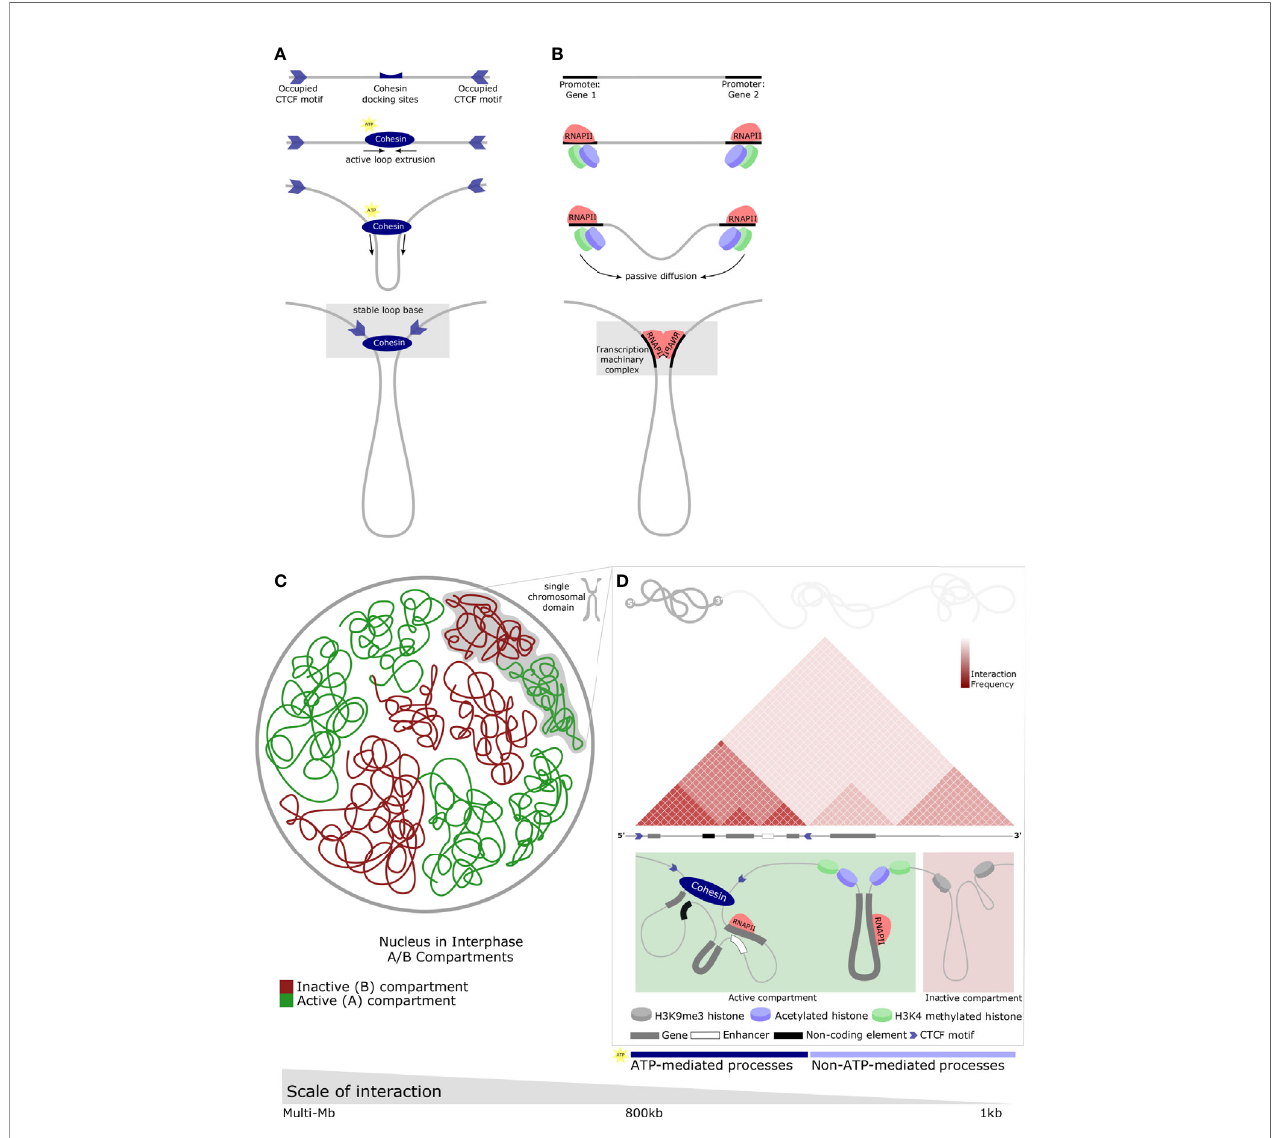
FIGURE 1 | Diverse chromatin structures across the range of nuclear scale and the main proposed regulatory mechanisms which underlie chromatin structure. (A) CTCF-mediated looping forms TADs. Directional CTCF motifs across the genome are occupied by CTCF in relation to loading/unloading dynamics of nuclear proteins. Similarly, Cohesin binds chromatin (top panel) and extrudes chromatin through its closed ring structure to form a loop (middle panels). Extrusion continues bidirectionally until convergent CTCF occupied sites are encountered. Heterodimerization of CTCFs, Cohesin, and various other proteins form a stable loop anchor complex (bottom panel) and are the basis of most stable TAD structures. (B) RNAPII-mediated looping forms small chromatin loops. TFs bind motifs in the regulatory elements of genes along with RNAPII (top-middle panel). Passive diffusion and random motion which are not ATP-mediated bring these protein structures into proximity with one-another (middle-bottom panel) and, by means of af fi nity-interactions, chromatin loops form between regulatory elements (bottom panel). These protein-protein interactions may result in liquid-liquid phase separation and the relatively dynamic recruitment of transcriptional machinery, creating a permissive environment for rapid and robust transcription. (C) Nuclear compartments are complex chromatin structures. In interphase, the nucleus is divided into A and B compartments. These domains span multiple megabases and comprise active (gene-dense, euchromatin) and inactive (gene-scarce, heterochromatin) possibly mediated by liquid-liquid phase separation. Green - active or A compartment; red - inactive or B compartment. (D) Multiple different chromatin loop structures are contained within single chromosomes which contribute to A or B compartments. Individual chromosomes can contain contiguous regions of active or inactive chromatin which represent the interactions of various elements of the genome facilitating functional regulation. These chromatin interactions are depicted by a schematic of a Hi-C map demonstrating a small area of a single chromosome in interphase. Triangular regions of varying red intensity represent the likelihood of interactions between chromatin regions in a population of cells. TAD with boundaries occupied by convergent CTCF motifs insulate areas of the genome (left). Similarly, the active compartment contribution of this representative chromosome may house RNAPII-mediate loops mediating interactions between genes, or genes and non-coding regulatory elements (as described in B ) (middle). The inactive compartment contribution may be mediated by protein-mediated liquid-liquid phase separation to form repressive compartmental domains in gene-scarce heterochromatin (right). These processes can be either ATP- or